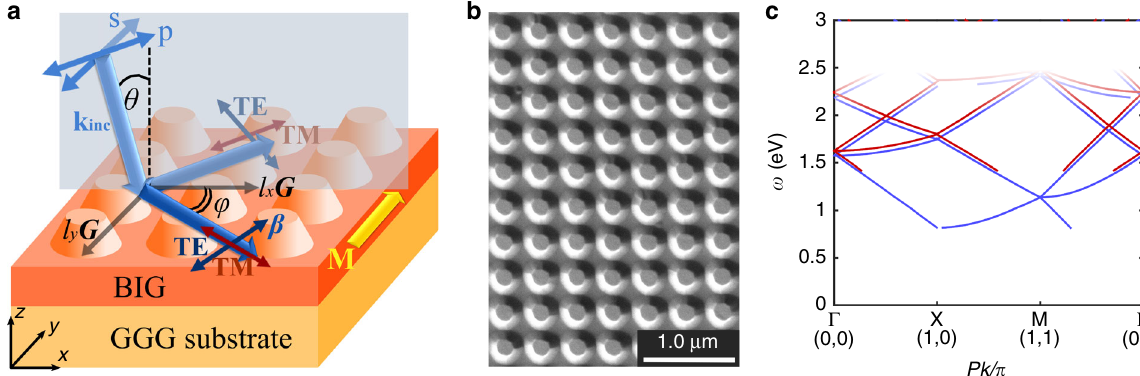
Fig. 1 Magnetic metasurface. a Scheme of the sample and mode excitation; b SEM image of the fabricated structure. c Dispersion diagram for the TM- (red color) and TE- (blue color) modes in 2D magnetic metasurface with a smooth BIG underlayer. Line whitening corresponds to the absorption frequency range of the BIG